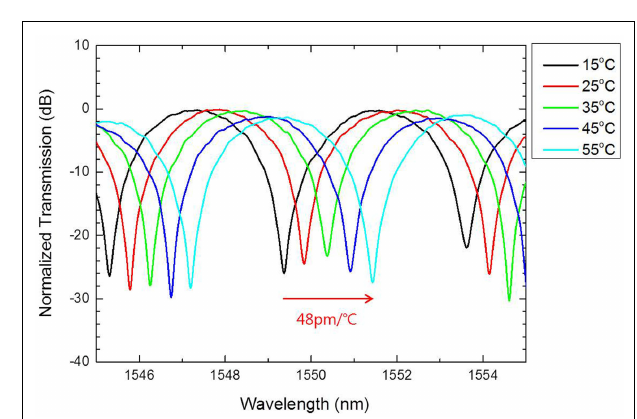
FIGURE 1 | (A) Schematic diagram of asymmetric MZI with arms different in length and cross-sectional dimension of waveguide, and schematic diagram of the cross-section of the arms in (B) with silica cladding and (C) with titania cladding, respectively.